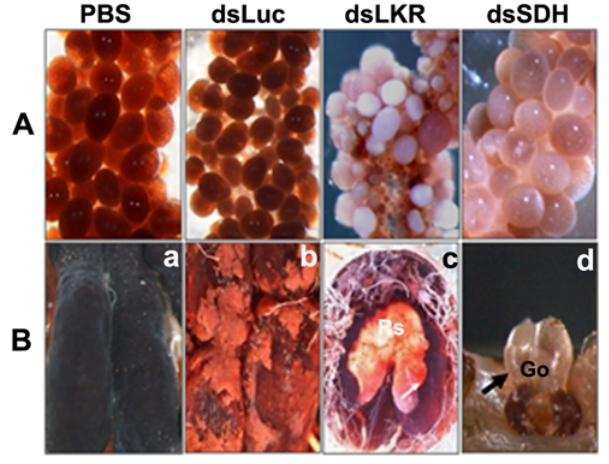
Figure 11. Microphotographs of dsRNA-injected tick and macro photograph of pathological organs. A. Ovaries of PBS (normal), LKR and SDH dsRNA-injected ticks showing pathological phenotypes. B. Macrophotograph of pathological organs. Panel a, Normal midgut of PBS-injected ticks on day 25 after engorgement, Mg, midgut; panel b, Destroyed structure and appearance of liquid in the midgut of LKR dsRNA-injected tick on day 25 after engorgement, Mg, midgut; panel c, Magnification of Figure 11E, rectal sac of LKR dsRNA- injected tick on day 25 after engorgement shows significant enlargement due to filling with fluid-like redden liquid, Rs, rectal sac; panel d, Hernia-like protrusion of Gene’s organ, LKR dsRNA-injected tick on day 14 after engorgement, Go; Gene’s organ.